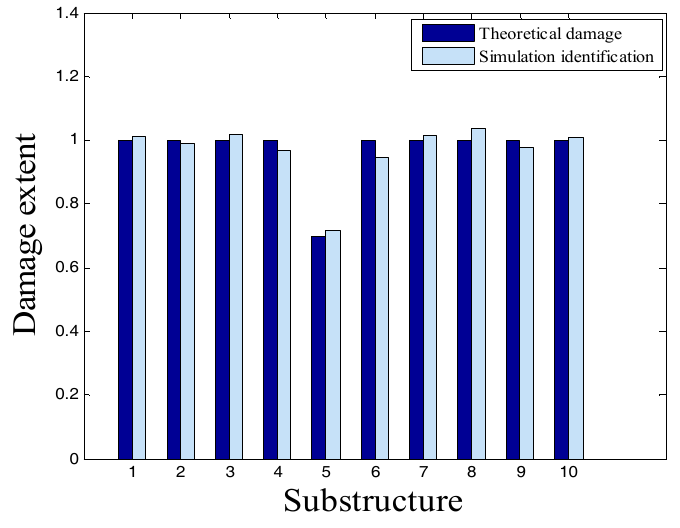
Figure 11. Case 1: identified damage extents.